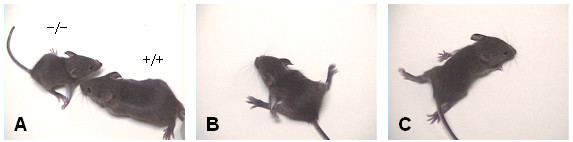
Uncoordinated movements in the Adam22 (-/-) mice at postnatal day 18 (P18). (A) Adam22 (-/-) mice were smaller than their wild-type (+/+) littermates. (B, C) Adam22 (-/-) mice at P18 were unable to support themselves on their hindlimbs.